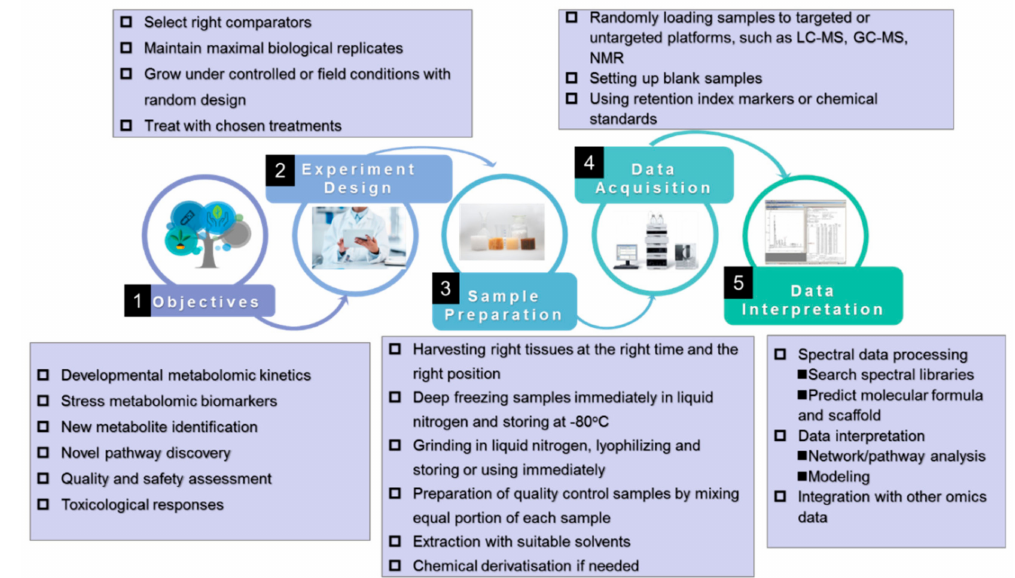
Figure 1. An overview of the pipeline of a plant metabolomics study. LC-MS, liquid chromatography mass spectrometry; GC-MS, gas chromatography mass spectrometry; NMR, nuclear magnetic